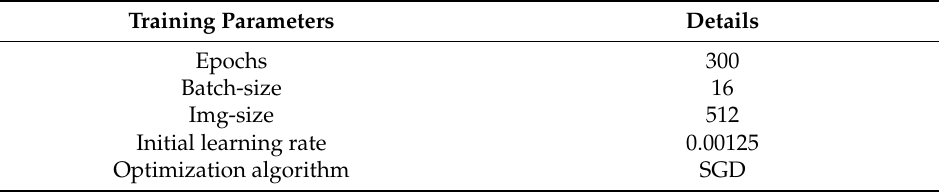
Table 3. Training parameters of our improved model.